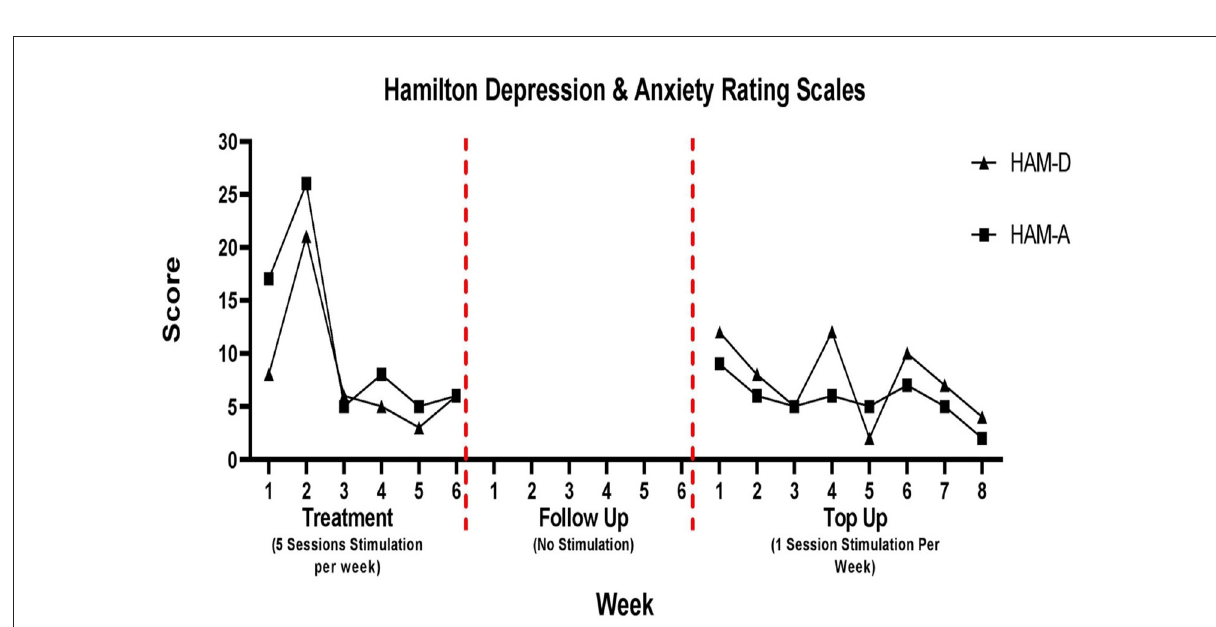
FIGURE4 Hamilton Rating Scale for Depression (HAM-D) and Anxiety (HAM-A).